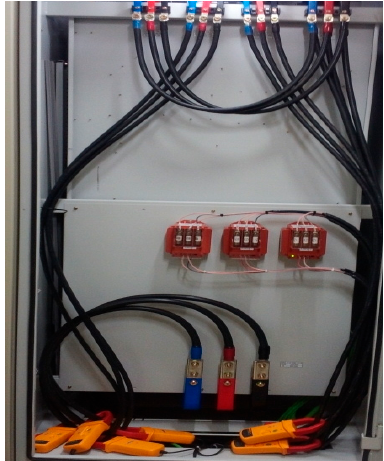
J. Mar. Sci. Eng. 2019 , 7 , x FOR PEER REVIEW Figure 11. Installed voltage measuring equipment. Figure 11. Installed voltage measuring equipment.